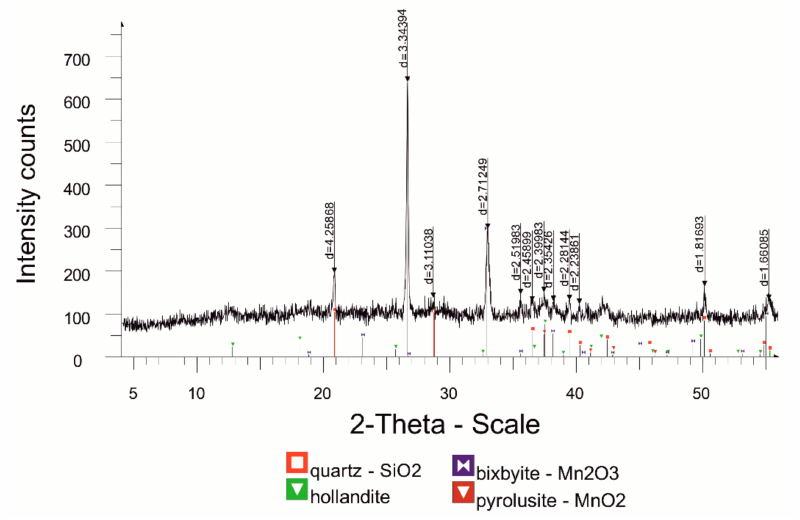
Figure 9. Diffractogram of manganese ore sample from the Zhaksy deposit. Table 8. Infrared radiation absorption values of manganese monomineral fractions, oxide and carbonate manganese ores determined by IR spectroscopy [31].